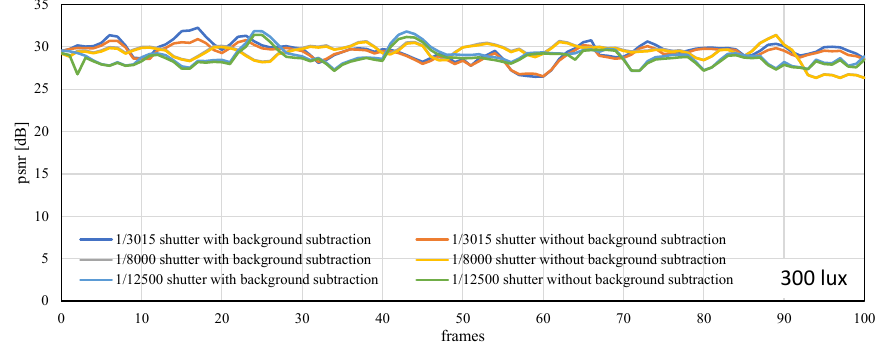
Figure 26. PSNRs when the USB camera video sequence is streamed through HFR projector-2.